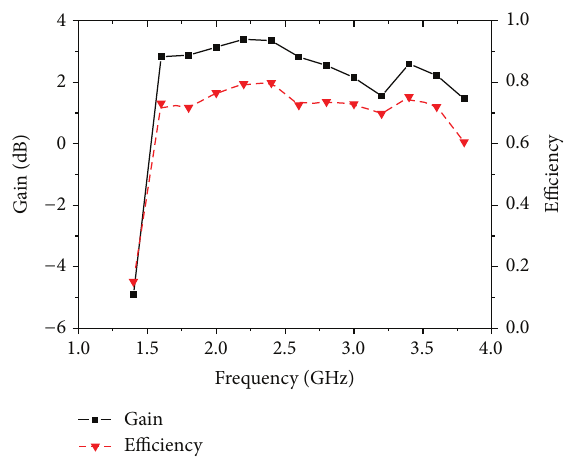
Figure 8: Measured gain and efficiency of the proposed antenna.